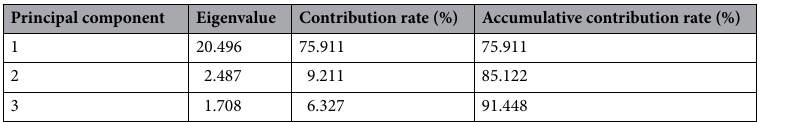
Table 6. Eigenvalues and cumulative contribution proportions of principle components of the